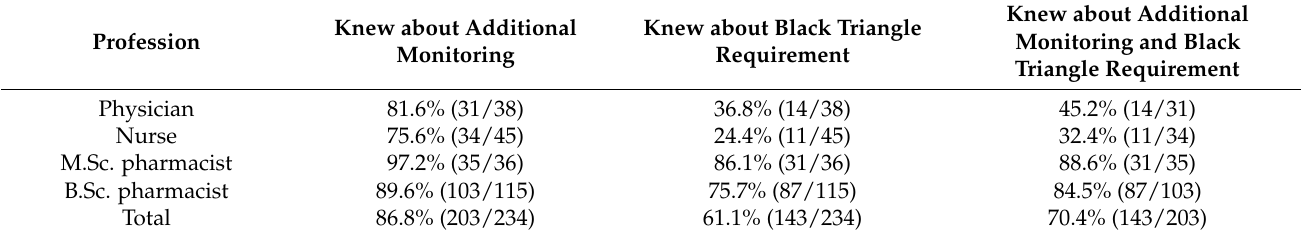
Table 4. Percentage of HCPs who knew about the additional monitoring concept and black triangle requirement.